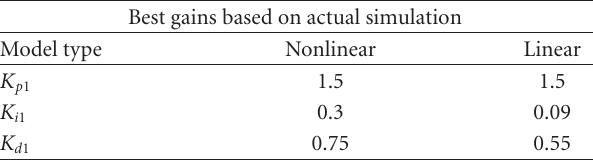
Table 7: Best PID controller parameter using actual simulation.